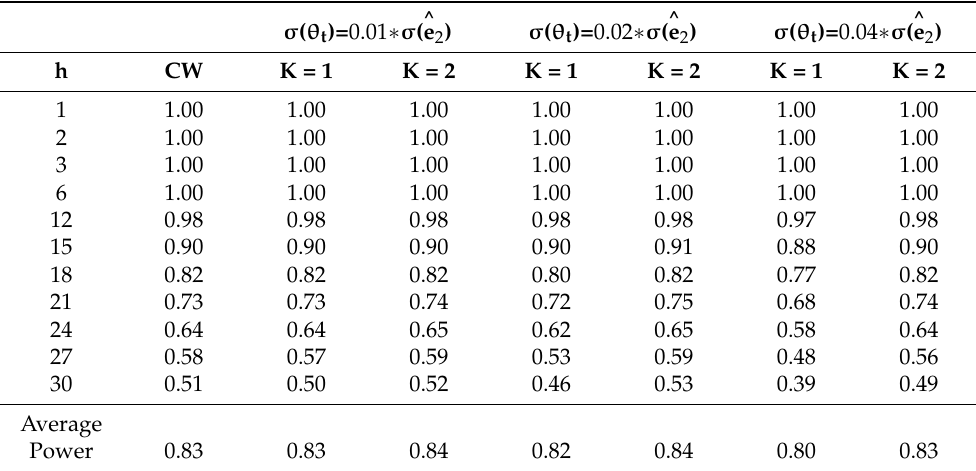
Table 11. Power comparisons between CW and WCW tests with nominal size of 10%, considering DGP3 and a large sample.